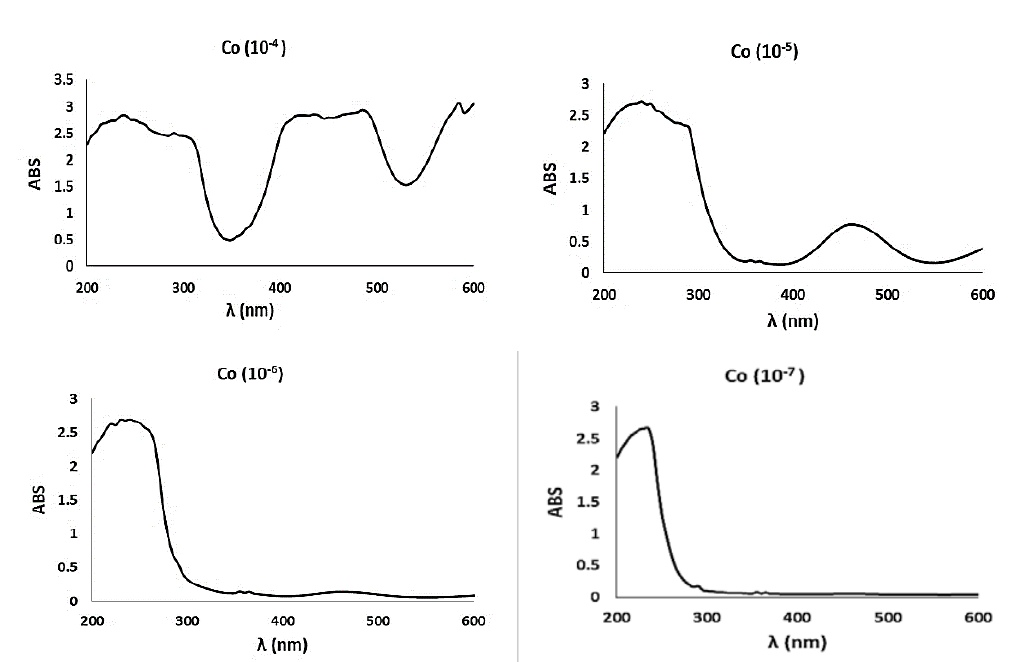
Fig.2: Absorption spectrum of iron chloride with concentrations of Fig.3 illustrates the absorption spectrum of